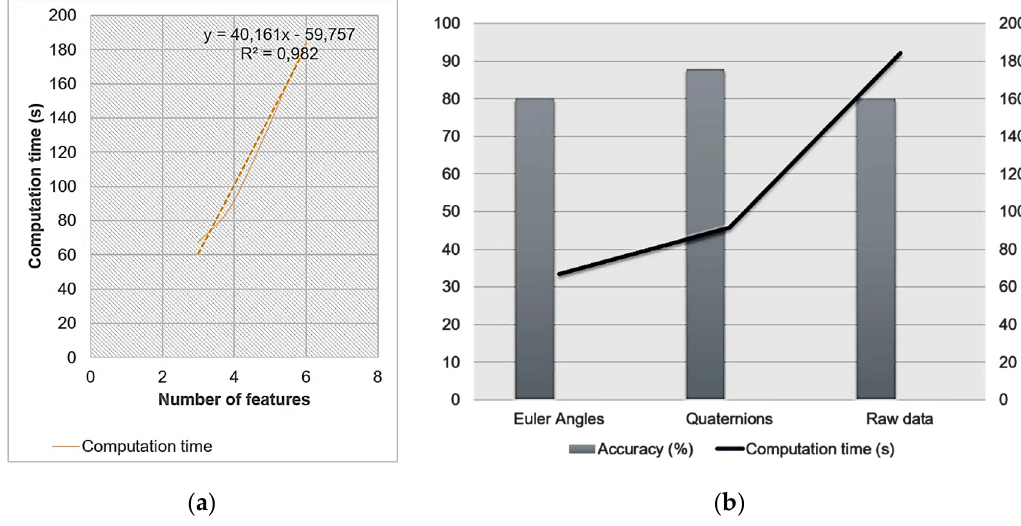
Figure 13. ( a ) Computation time vs. number of features; ( b ) Accuracy vs. computation time.